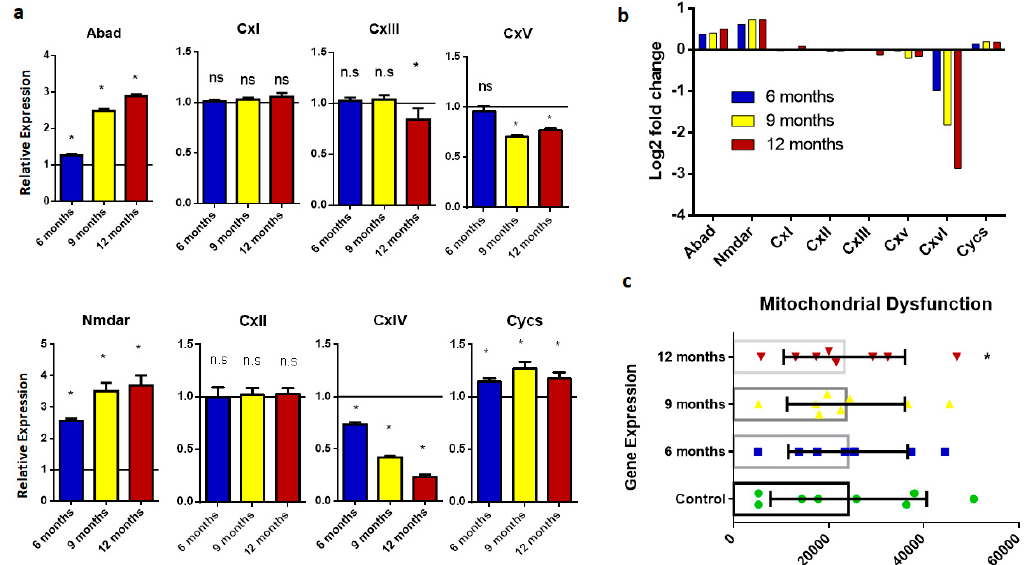
Figure 5. Expression analysis of genes involved in mitochondrial disruption. ( a ) Histograms representing relative m RNA expression of Abad , Nmdar , Cx i–v , and Cycs . Represented values are the mean and SD obtained from three individual experiments performed for each sample. The line on the x-axis at 1.0 represents the gene expression of control samples. ( b ) Bar plots representing fold-change values represented in the log2 scale showing comparative gene expression in the brain of six-, nine-, and 12-month-old samples. Baseline shows expression in control samples. ( c ) Scattered-dot plot showing expression of genes involved in mitochondrial dysfunction. * Expression is significantly different to WT ( p ≤ 0.05). n.s., Nonsignificant.